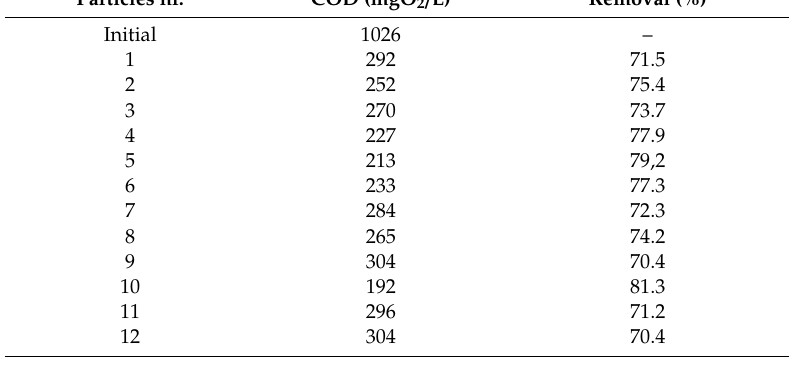
Table 3. Initial and final chemical oxygen demand (COD) values and removal % by the sorption process. Particles nr.